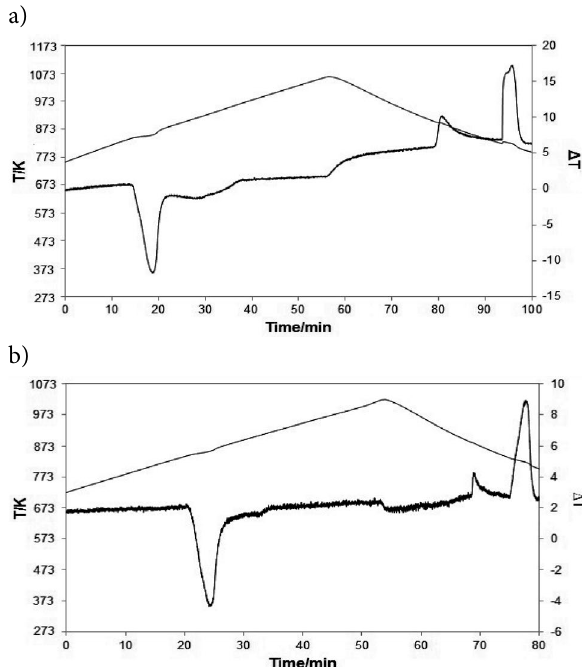
Figure 11. Thermograms for (SnAs) 0.5 (GeAs 2 ) 0.5 (a) and (Sn 0.39 As 0.61 ) 0.7 (Ge 0.28 As 0.72 ) 0.3 (b) alloys.